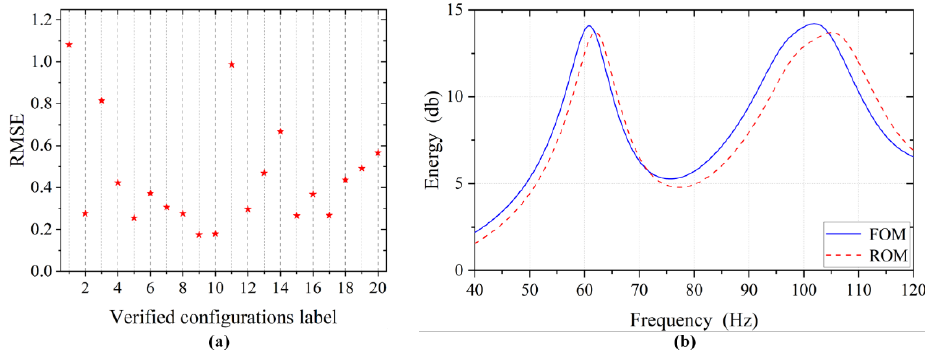
Figure 6. Accuracy of the verified configurations computed by initial global POD ROM: ( a ) RMSE values; and ( b ) energy–frequency curves of the No.1 verified configuration.